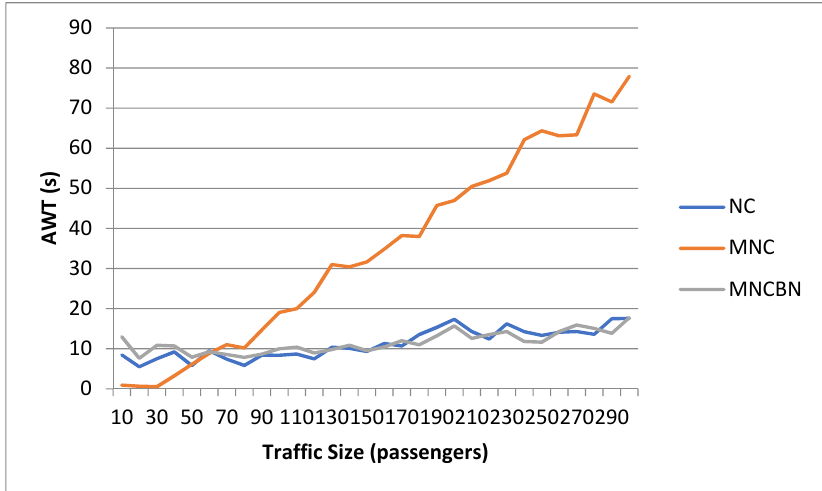
Figure 6. Dependence of average journey time (AJT) on change in traffic size.